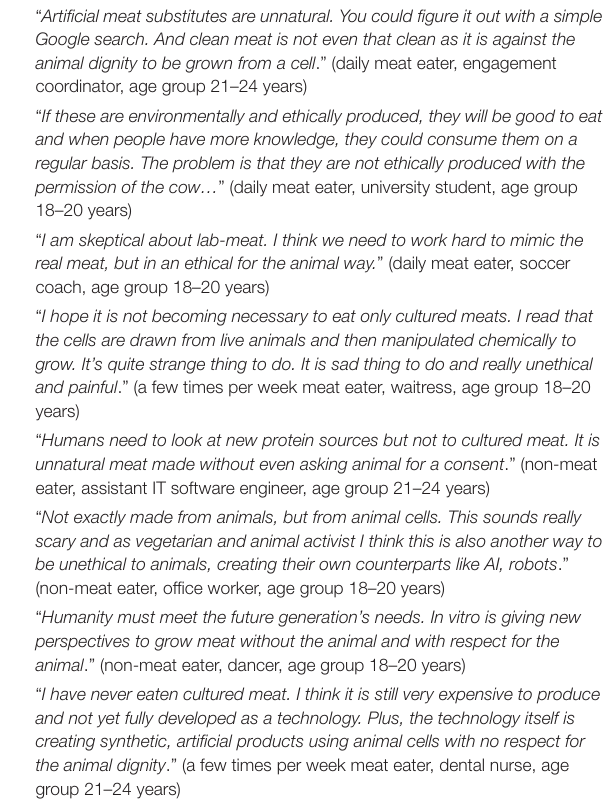
TABLE 8 | Animal welfare concerns by Sydney Gen Z.